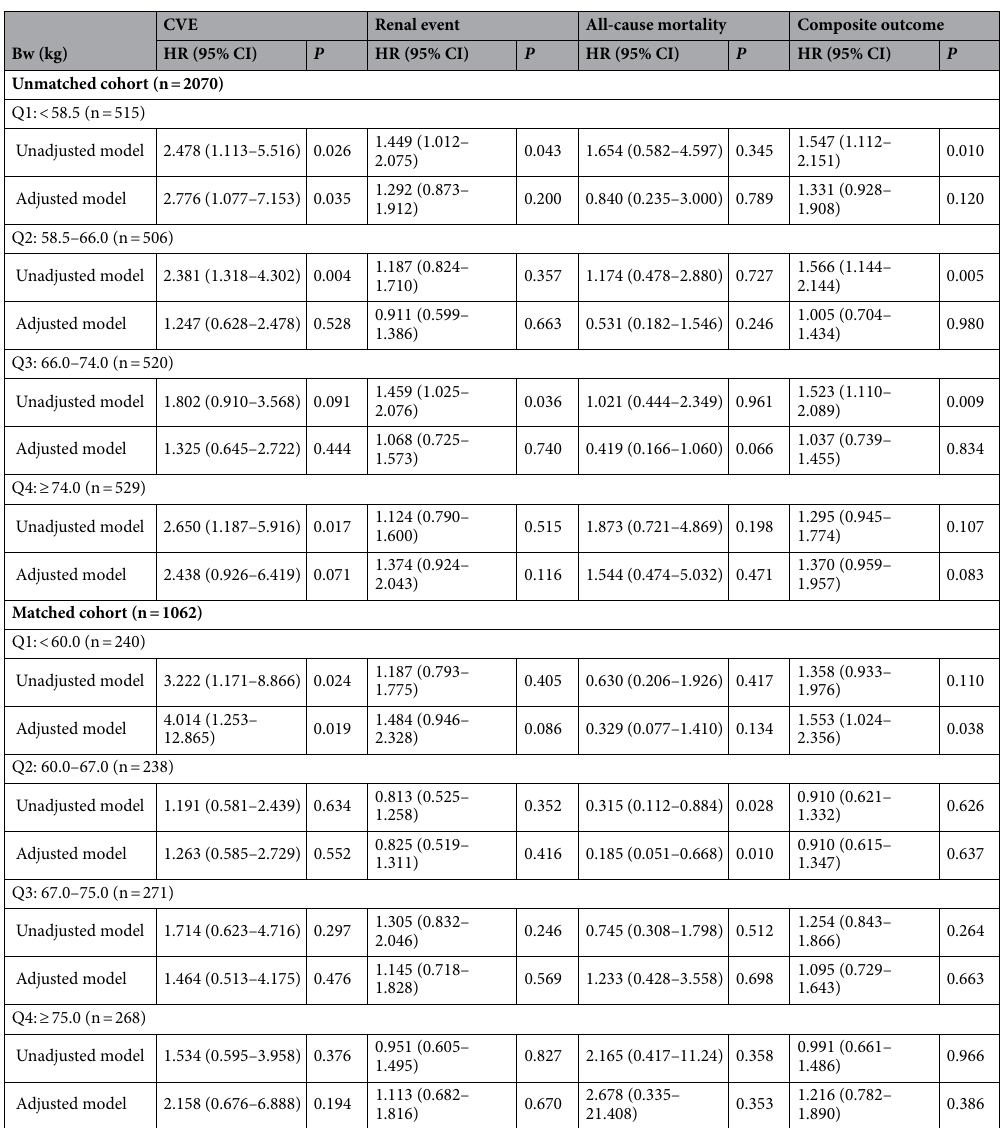
Table 3. Multivariate Cox proportional analyses for clinical outcomes according to the group of bodyweight. Adjusted for age, male gender, BMI, smoking, baseline eGFR, previous CVD, diabetes, hypertension, proteinuria, hemoglobin, albumin and total cholesterol levels, and use of medications (RAAS blockers, CCB, beta-blockers, statin, warfarin, and other antiplatelet